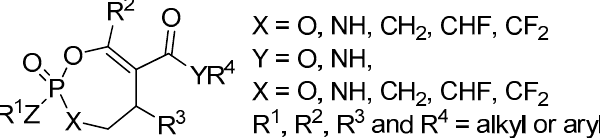
Figure 6. A general structure of enolphosphonates and enolphosphates.